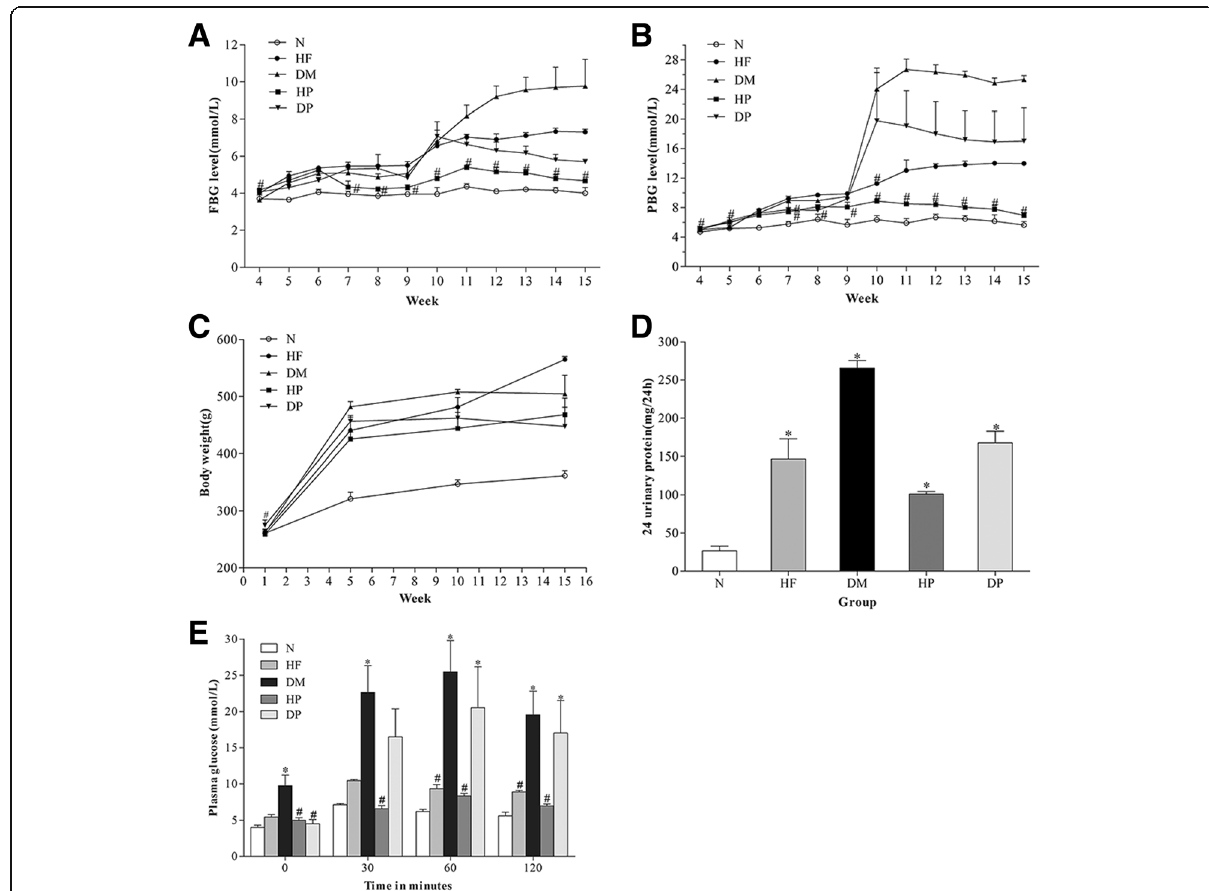
Fig. 2 a , FBG levels. b , PBG levels from 4th week to 15th week. c , Body weight in each month. d , 24 h urinary protein at the end of the study. e , the result of OGTT of all rats. Results are presented as mean ± SEM, n ≥ 3. # indicates p > 0.05 compared with the normal group in Fig. 2a, b & e. * indicates p < 0.05 compared with the normal group in Fig. 2d &